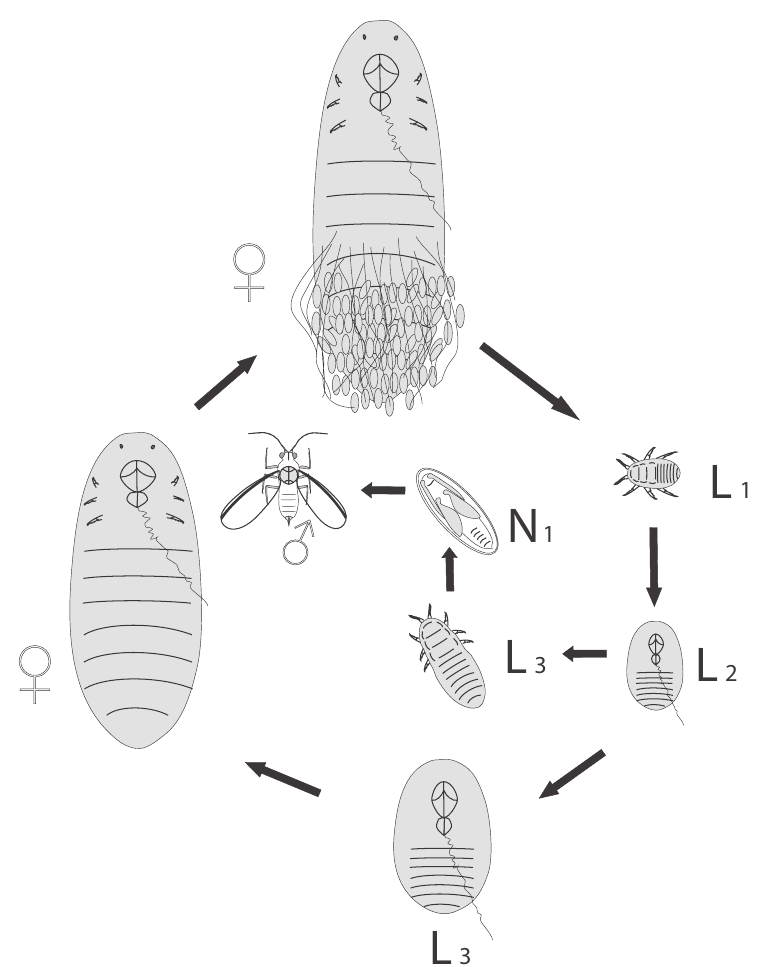
Figure 3. The life cycle of Jansenus burgeri Foldi, 1997; L – nymphal (preimaginal) stage with protoptera (wing buds) of